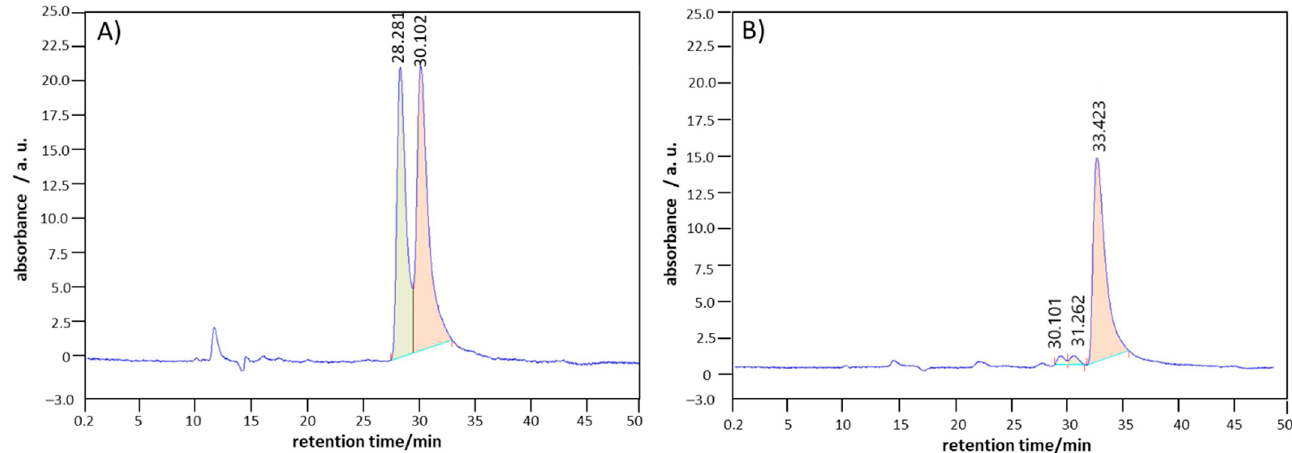
Figure 5. HPLC separation of epoxide 8 on chiral phase. ( A ) racemate 8 and ( B ) epoxide 2 S ,3 R - 8 . 2 R ,3 S isomer is marked green; 2 S ,3 R isomer is marked red.